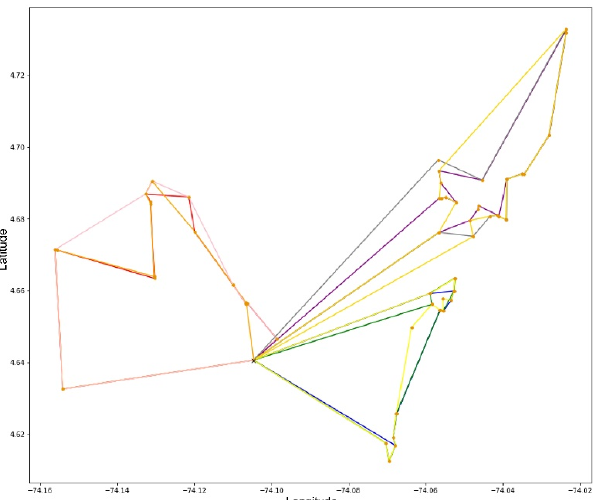
Fig. 5 . K-means clusters